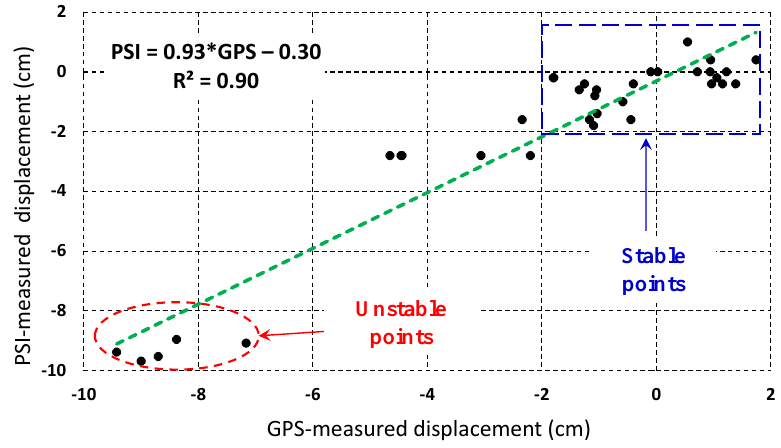
Figure 11. Comparison of PSI and GPS derived displacements (October 2014 to October 2016).